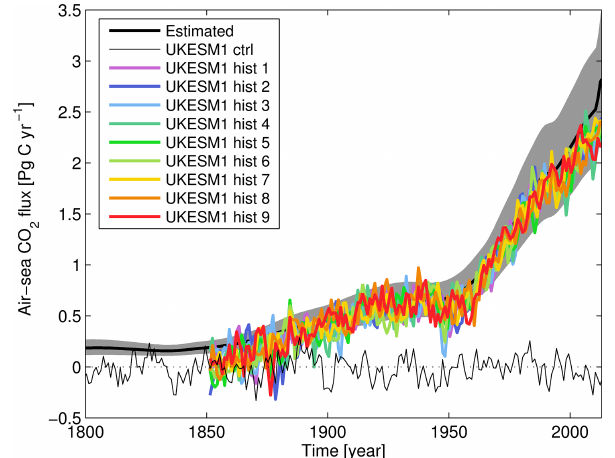
Figure 17. Time series of globally integrated air-to-sea CO 2 flux, showing observationally estimated mean (solid black) and range (grey shading; Khatiwala et al., 2009) and simulated piControl (thin black) and historical ensemble (solid colours). Air-to-sea fluxes are given in PgCyr − 1 . Note that while the historical era of CMIP6 ex- periments begins in year 1850, the Industrial Revolution – and up- take of anthropogenic CO 2 by the ocean – began prior to this date.